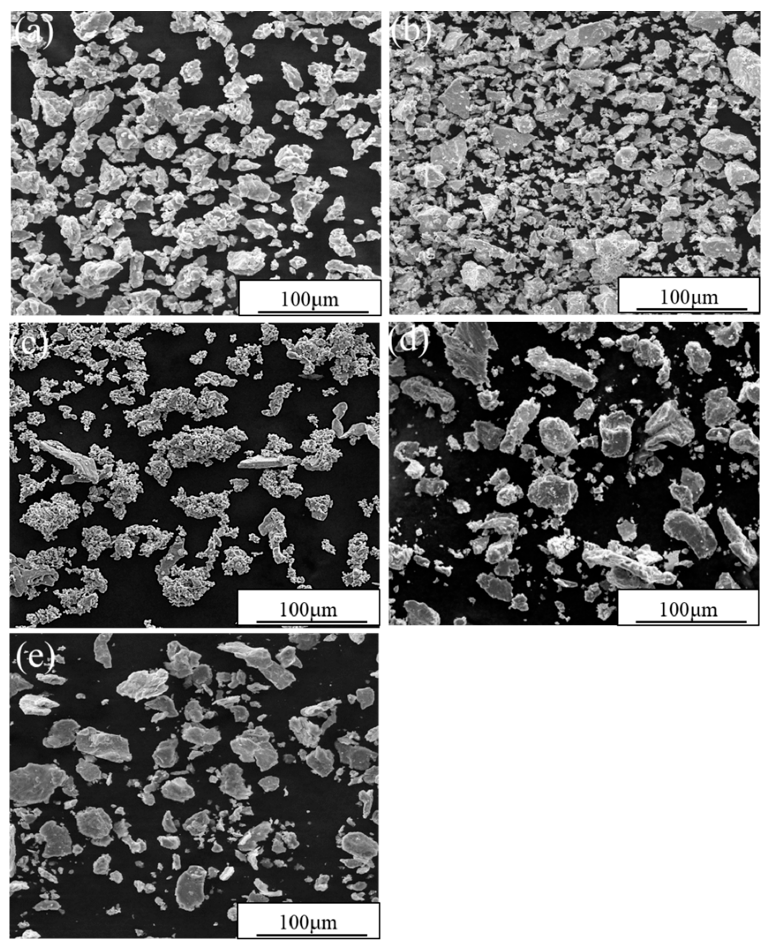
Figure 1. SEM images of primary metal particles (Ti, Nb, Ag)) and as-milled Ti-40Nb and Ti-40Nb- 10Ag particles. ( a ) Ti; ( b ) Nb; ( c ) Ag; ( d ) Ti-40Nb; ( e ) Ti-40Nb-10Ag.